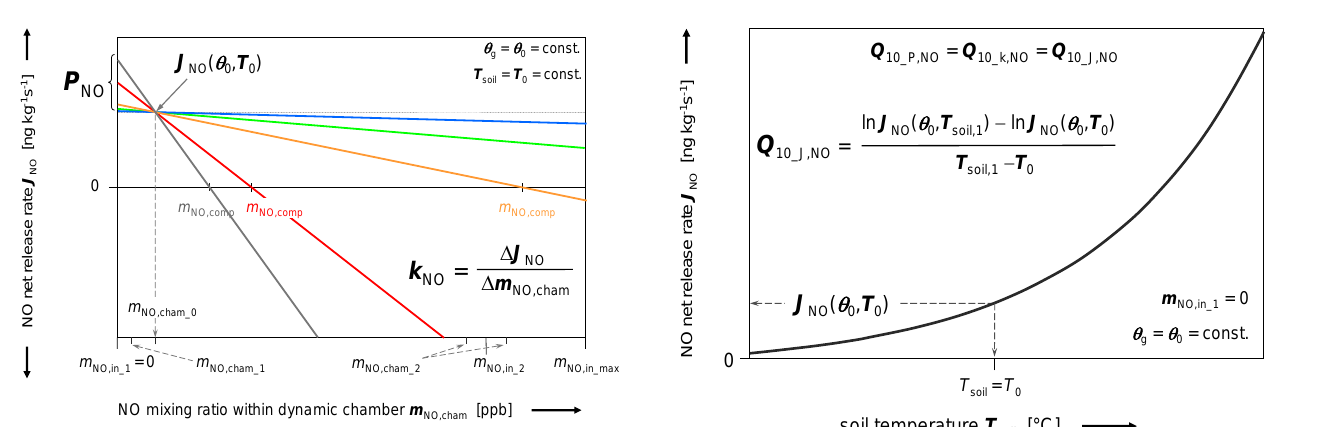
Figure 2. Schematic of NO net release rate J NO vs . tempera- ture T soil of the enclosed soil sample at constant gravimetric soil moisture and “zero”-air at the dynamic chamber’s inlet (note: the Fig. 2: Schematic of NO net release rate J NO vs . temperature T soil of the enclosed soil shown exponential dependence for J NO (T soil ) is only valid, if Q 10 sample at constant gravimetric soil moisture and “zero”-air at the dynamic values of both, NO production ( Q 10_P , NO ) and NO consumption chamber’s inlet (note: the shown exponential dependence for J NO ( T soil ) is only ( Q 10_k , NO ) are identical; in this case Q 10_J,NO equals Q 10_P , NO = valid, if Q 10 -values of both, NO production ( Q 10_P,NO ) and NO consumption Q 10_k , NO , see Eq. ( Q 10_k,NO ) are identical; in this case Q 10_J,NO equals Q 10_P,NO = Q 10_k,NO , see Eq. (3.2)).